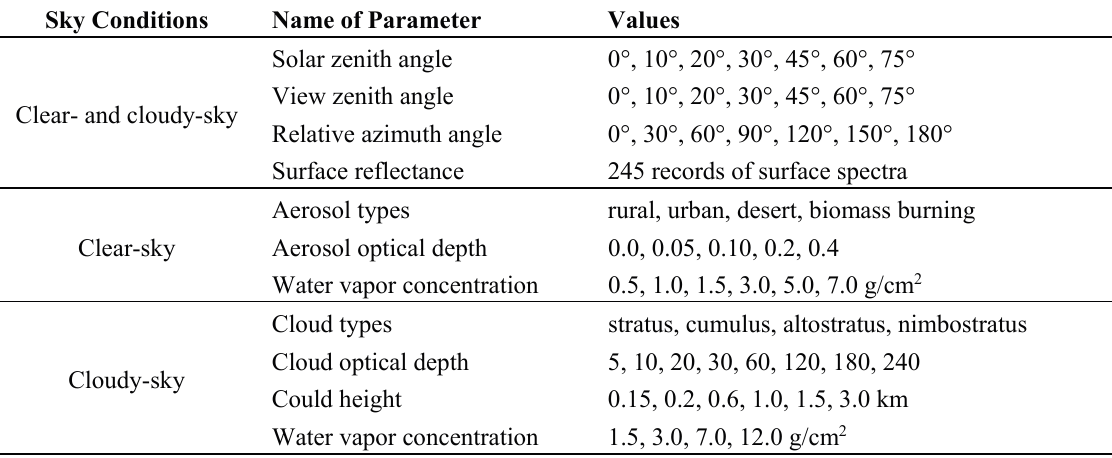
Table 1. Specification of major parameters used in atmospheric radiative transfer simulation.